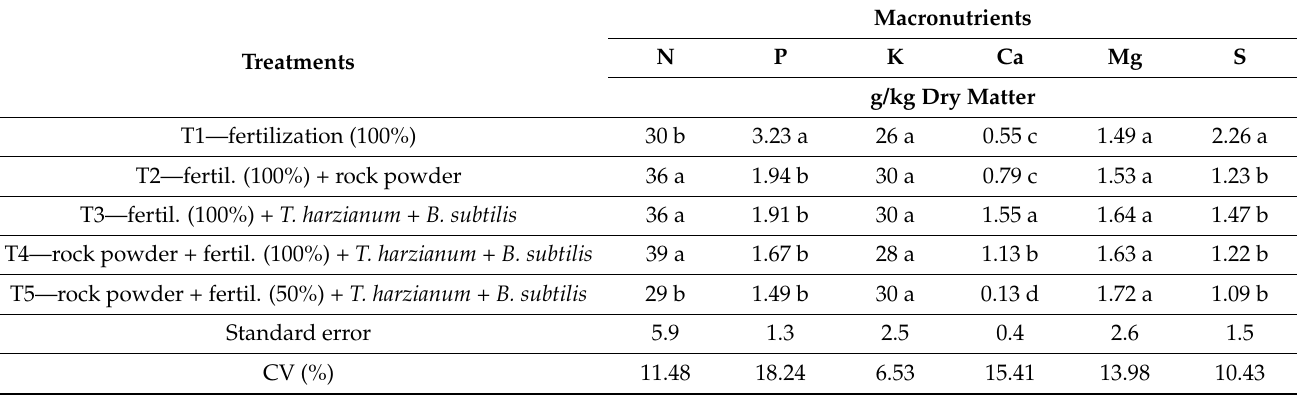
Table 4. Chemical analyses of the macronutrients nitrogen (N), phosphorus (P), potassium (K), calcium (Ca), magnesium (Mg), and sulfur (S) expressed in g/kg of dry matter, performed on maize leaves (40 DAE) with the association of Trichoderma harzianum, Bacillus subtilis , rock powder and conventional fertilization (experiment